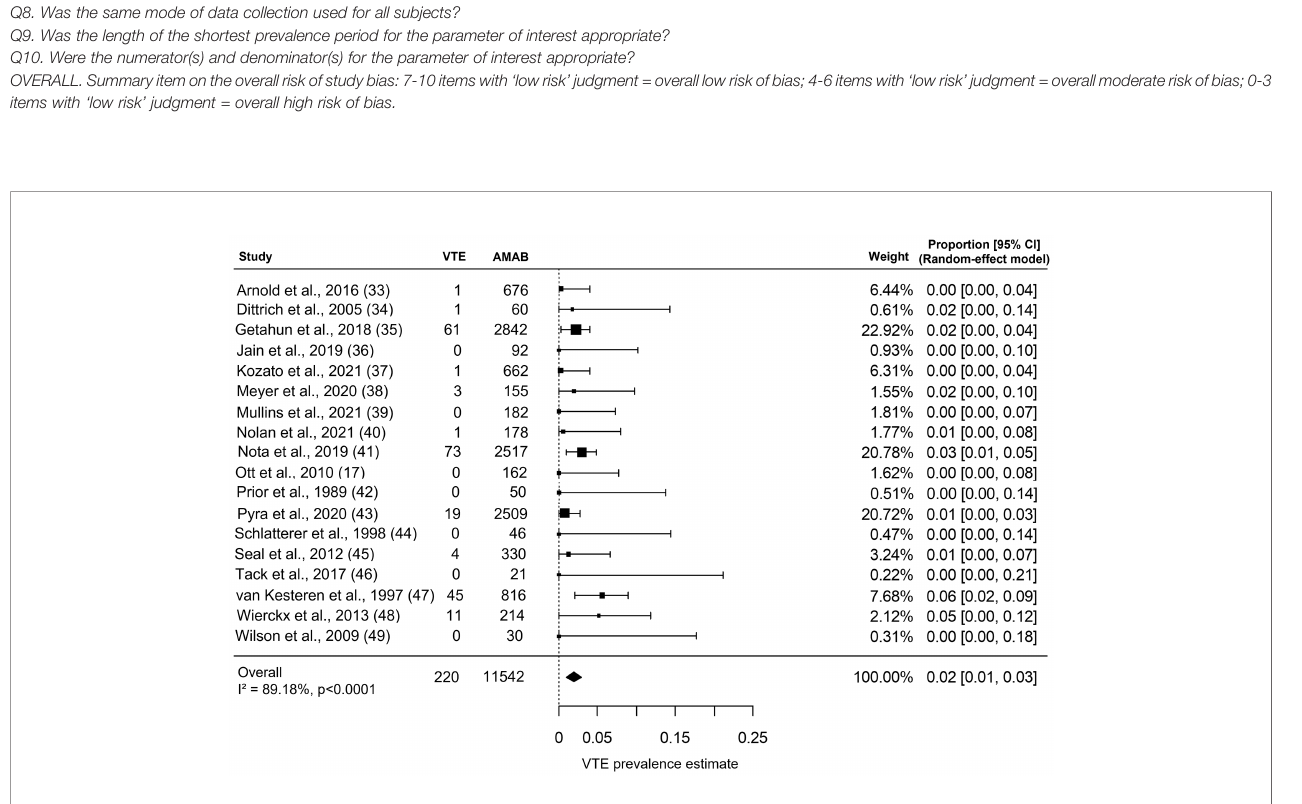
FIGURE 2 | Forest plot depicting the pooled prevalence estimate for venous thromboembolism (VTE) in Assigned Males at Birth (AMAB) trans people. Diamond indicates the overall summary estimate and the width of the diamond represents the 95% con fi dence interval (CI); boxes indicate the weight of individual studies in the pooled result.